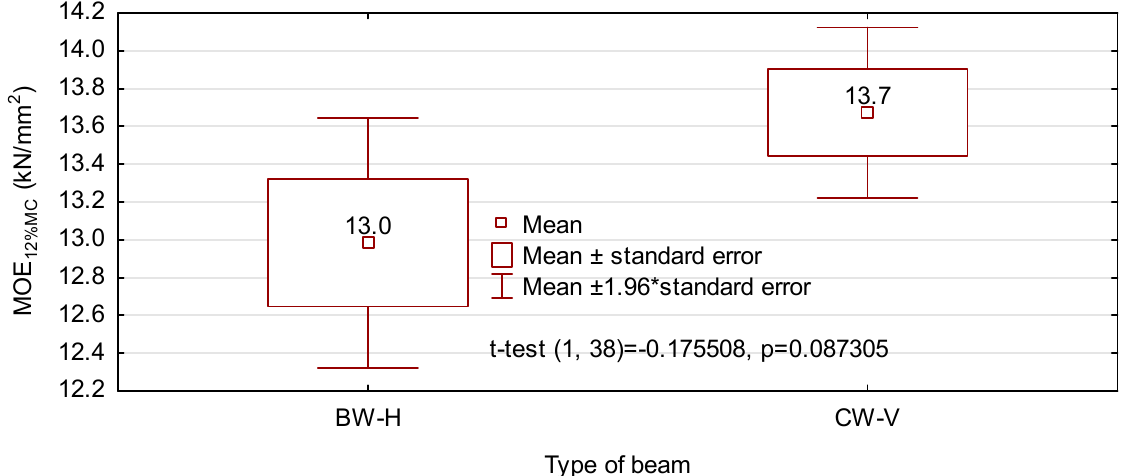
Figure 7. The modulus of elasticity of beams determined in the bending test.